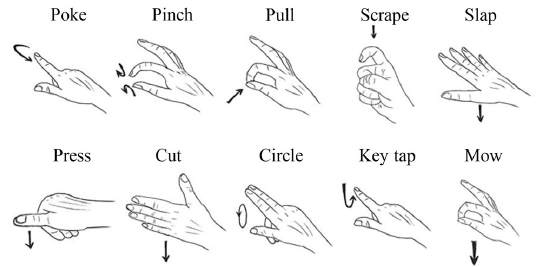
Figure 7. The illustration of ten gestures of the Handicraft-Gesture dataset.